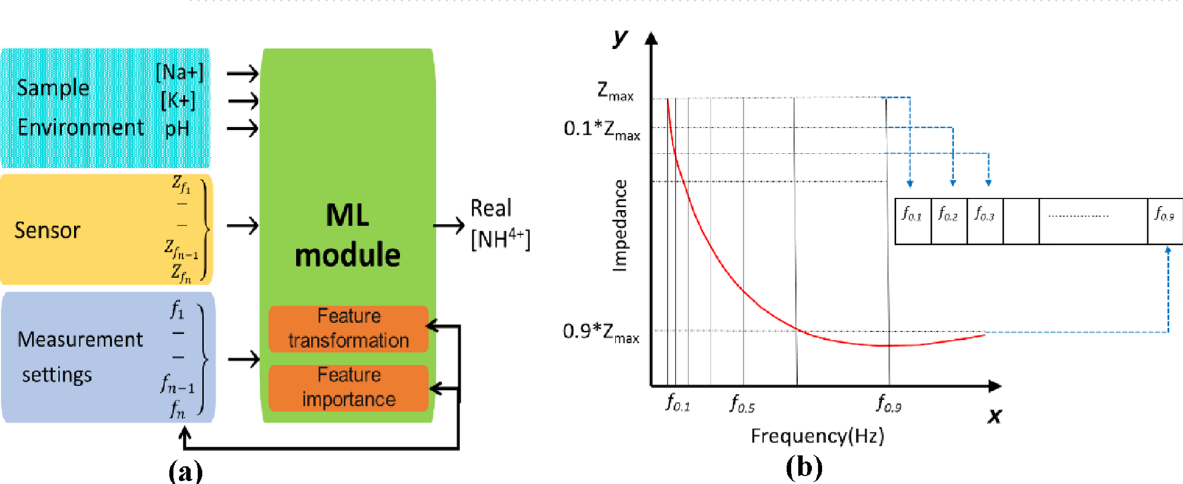
Figure 9. ( a ) Predictors of the ML model are extracted from Impedance Spectral features, sample parameters, and experimental settings. ( b ) Predictors f 0.1 to f 0.9 are the frequencies at which the impedance values are 0.1–0.9 times of Z max